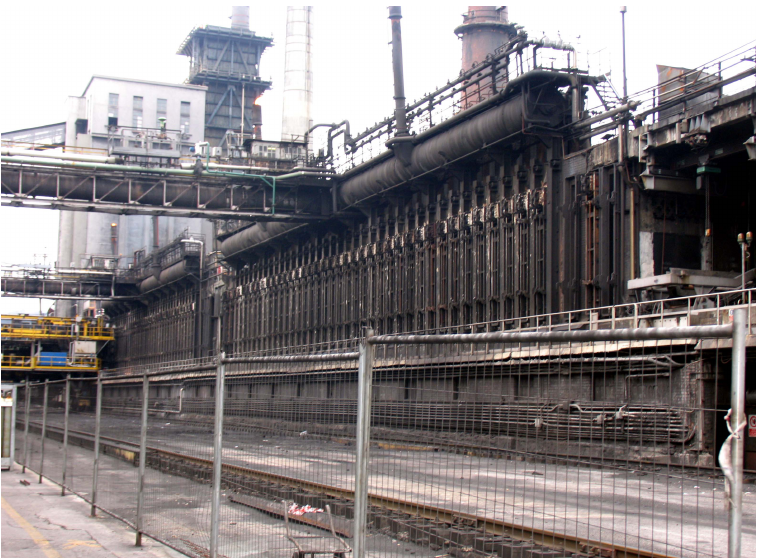
Figure 1. Picture of the industrial process plant.